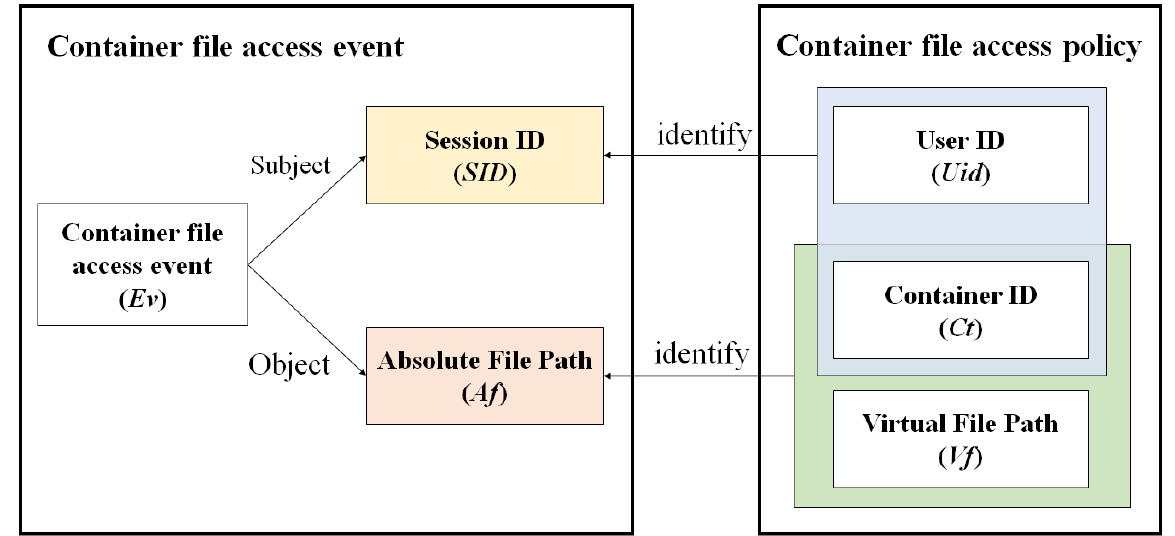
Figure 5. Structure of the container file access control policy.